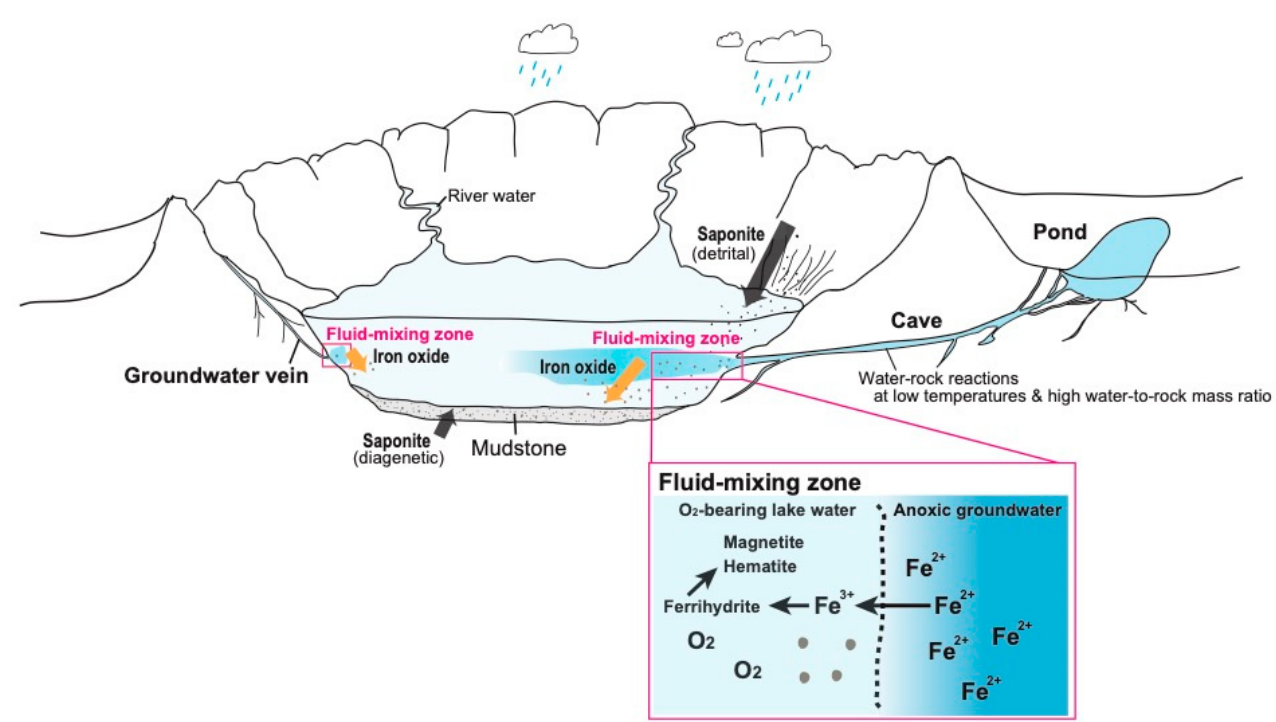
Figure 5. Schematic of possible formation scenario of saponite and iron oxides (magnetite and hematite) in Gale crater.